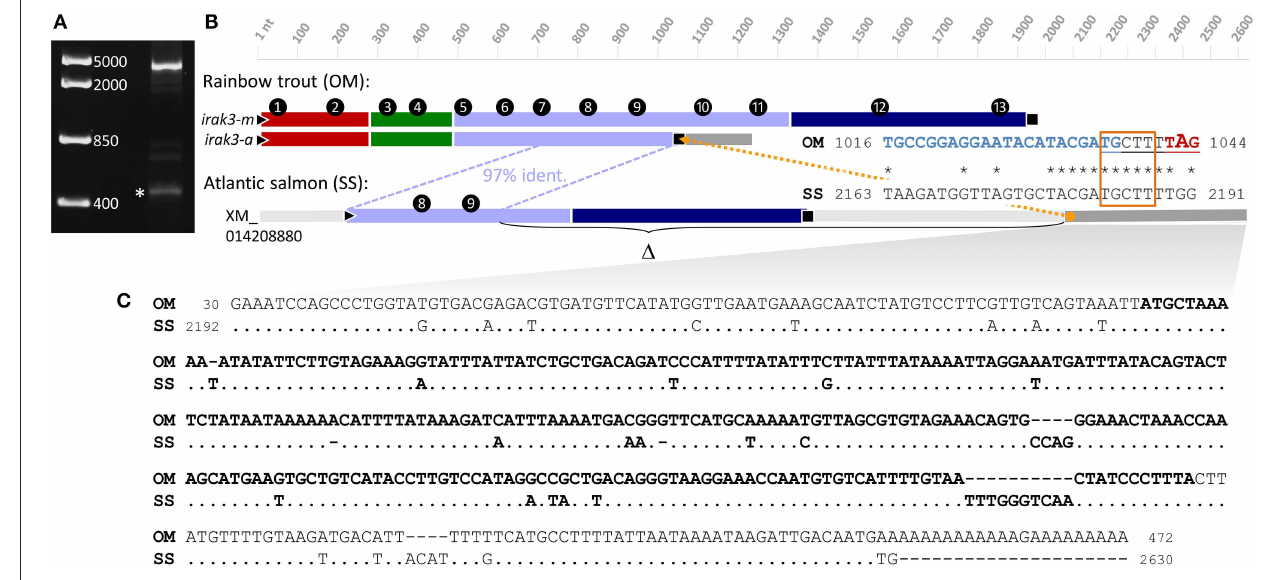
FIGURE 3 | (A) 3 ′ -RACE experiments using sense primers derived from exon 9 of the trout irak3 gene (c.f. Figure 2A ) produced two major bands of different length representing fragments of the truncated (marked with an asterisk) and the full-length transcript. DNA-marker bands are shown on the left. (B) Schematic comparison of the full-length ( irak3-m ) and truncated ( irak3-a ) transcripts of trout with the predicted Irak3-encoding fragment of salmon. Exons are numbered and sequences are drawn to scale; different colors indicate characteristic Irak3 domains as in Figures 1 , 2 . The homolog sequence shared by the coding irak3 fragment of the truncated variant and the salmon sequence is indicated with a blue dotted line. The orange dotted line marks the position of the nonamer sequence motif (underlined) not found in the full-length transcript. The alignment of a section containing the nonamer-sequence in the truncated trout sequence (OM; LN828695) and in the salmon sequence (SS; XM_014208880) is shown on the right. Start and end nt positions of the fragments are indicated. The sequence of the RACE primer f2 is shown in blue. The potential accessory splice site is framed in orange; the stop codon of the truncated irak3 transcripts is marked in red. (C) Alignment of the 5 ′ -UTRs of the truncated irak3 transcript from trout (OM; LR213462) and the predicted irak3 sequence from salmon (SS; XM_014208880). Identical bases in the SS sequence are indicated by dots. The retroposon sequence is highlighted in bold.